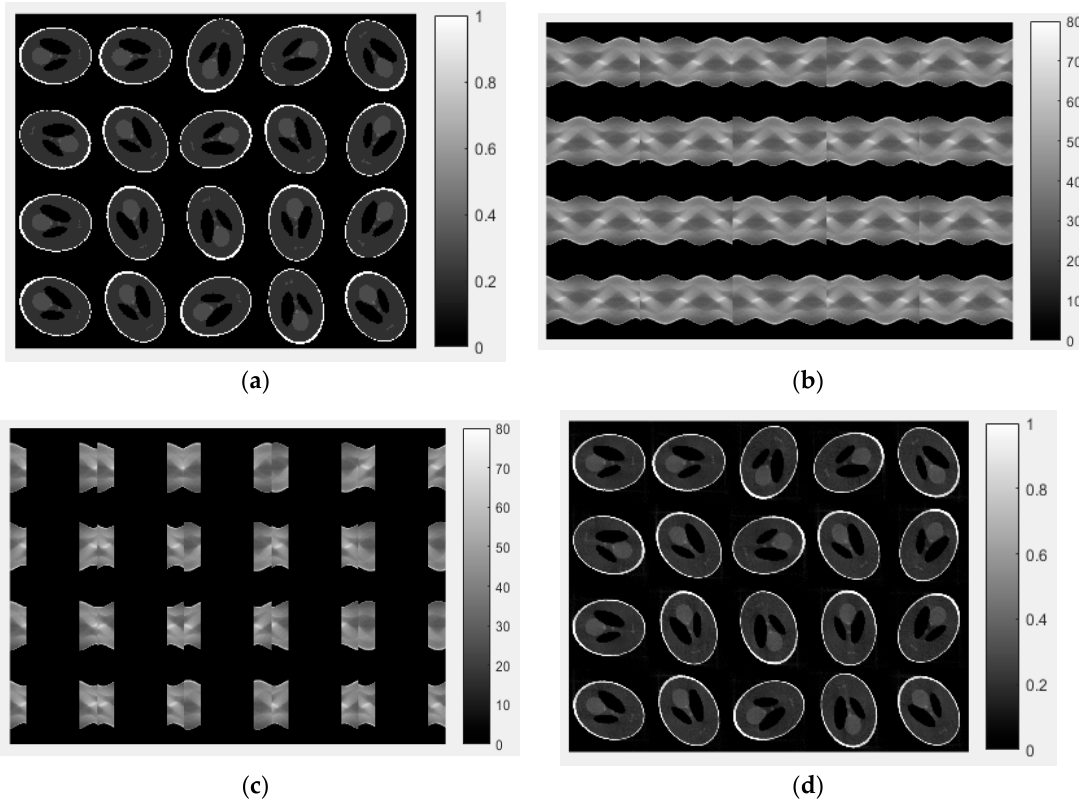
Figure 2. ( a ) Randomly generated 20 Shepp-Logan phantom images data using the Monte Carlo method. ( b ) Forward projection to generate corresponding sinogram data from 0 to 449°; ( c ) followed by the preprocessing rule to remove the data from 90 to 360° and to achieve the limited angle (LA) sinogram. ( d ) CT images reconstructed by context encoder (CE) inpainted sinogram. Table 3. The random number generated events according to Table 2. Simulation methods of image pre-processing to manipulate the LA sinogram before CE inpainting on the MATLAB platform.